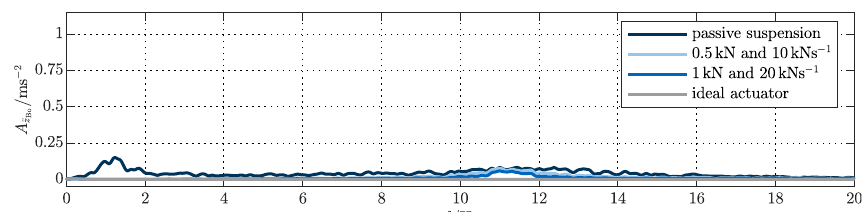
Figure A5. FFT of dynamic wheel-load for the AB profile at 90kmh − 1 .